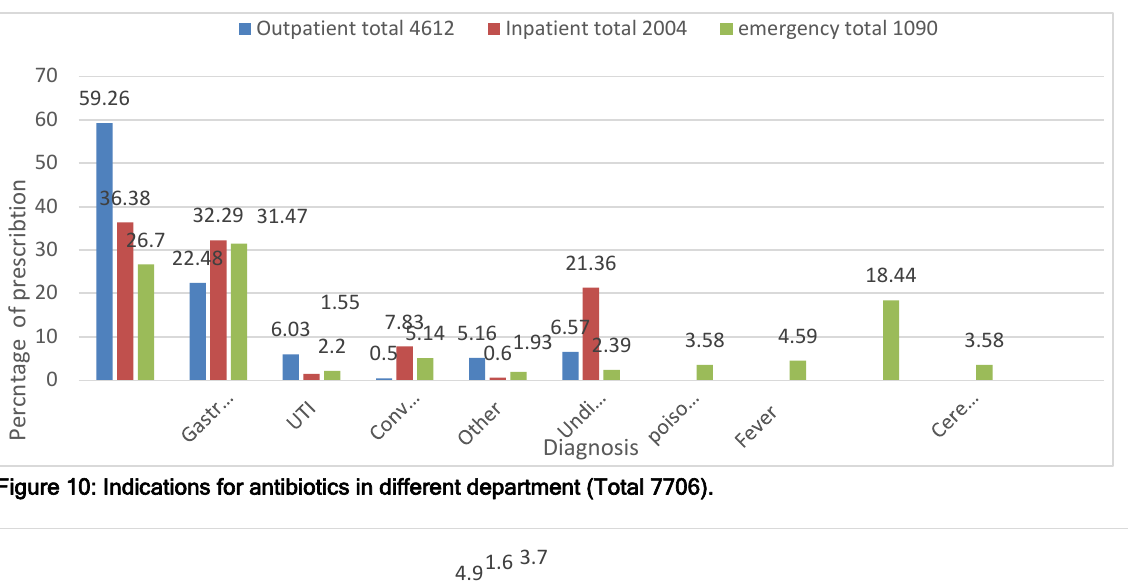
Figure 9: Triple antibiotics prescribed in NNCU (Total 22).